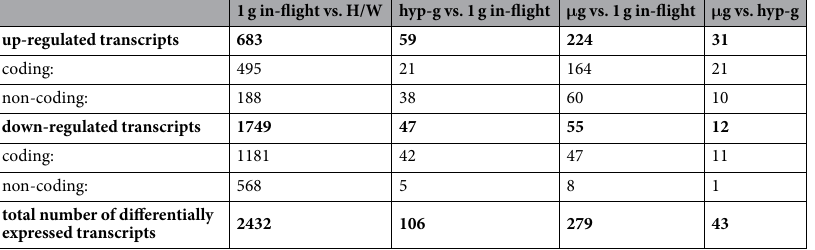
Table 1. Differentially expressed transcripts in T cells during the 23 rd Parabolic Flight Campaign. Number of significantly differentially expressed transcripts that were up or down-regulated in the respective comparison. H/W: hardware samples, hyp-g: hypergravity samples, μ g: microgravity samples. Fold change ± 1.3, p < 0.05.